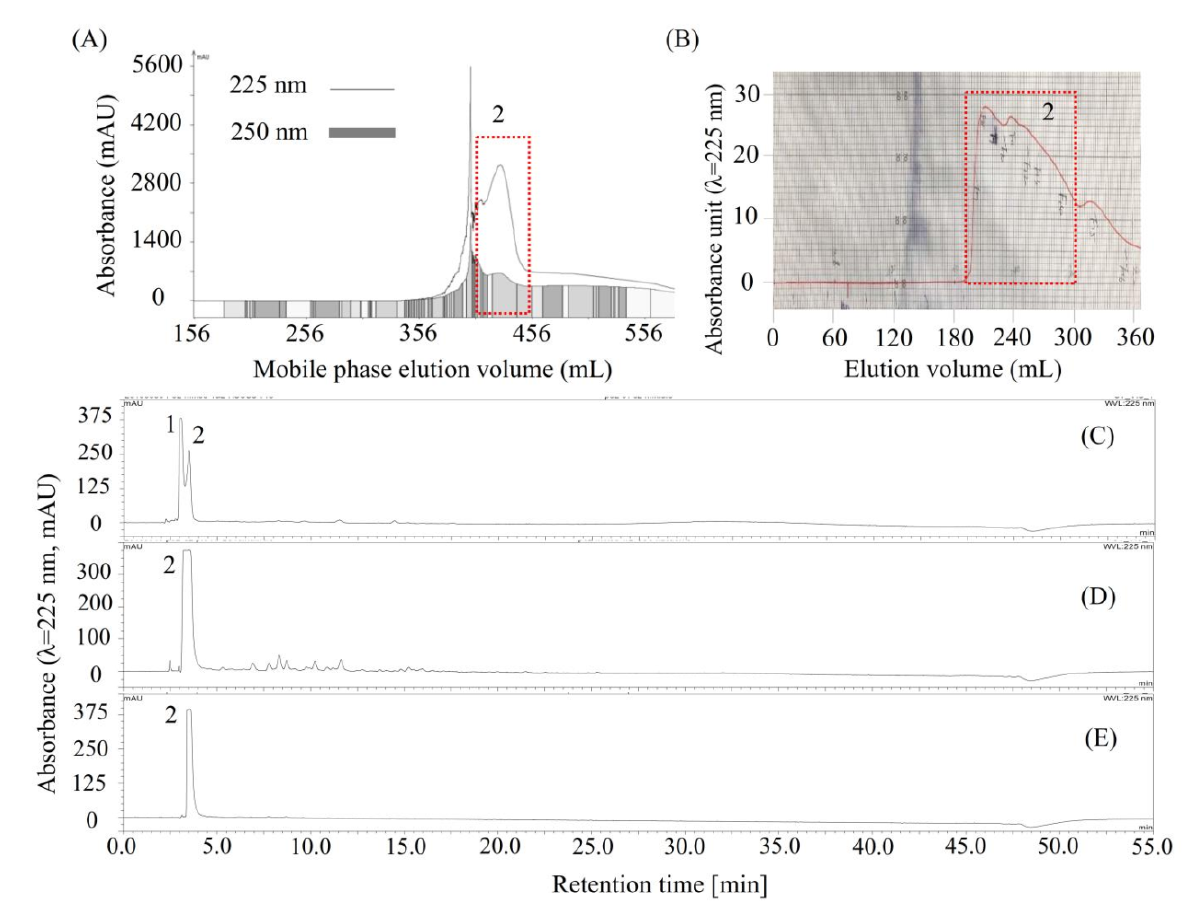
Figure 4. Chromatograms of high-speed counter-current chromatography (HSCCC), preparative HPLC, and analytical HPLC for the separation and purification of compound 2 . ( A ) HSCCC separation of 2 from the mixture of 1 and 2 ( C ). The eluate was monitored at 225 nm (line) and 250 nm (rectangle) and was automatically collected according to 250 nm; ( D ) Compound 2 separated by HSCCC; ( B ) preparative HPLC chromatogram for purification of 2 from impure compound 2 ( D ); ( E ) HPLC chromatogram of the purified 2 by preparative HPLC. Moreover, compound 2 is later identified as shikimic